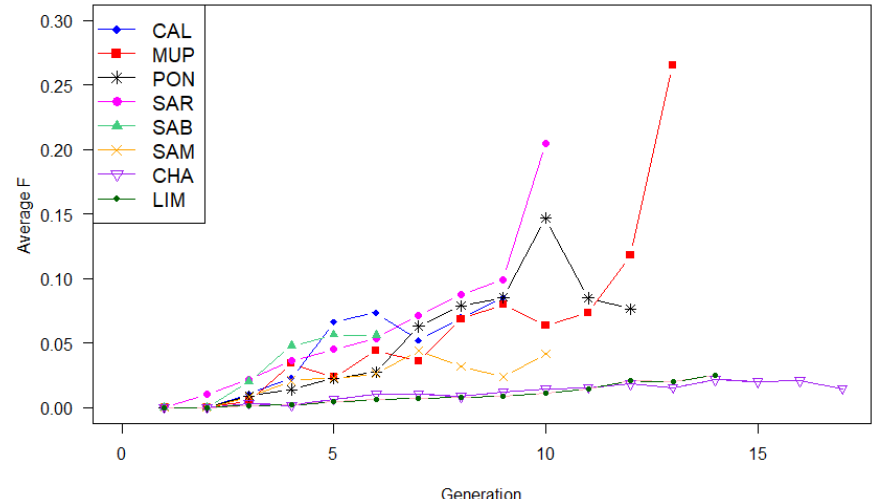
Figure 1. Rate of inbreeding ( ΔF ) per generation for each breed, where CAL = Calvana; MUP = Mucca Pisana; PON = Pontremolese; SAR = Sarda; SAB = Sardo Bruna; SAM = Sardo Modicana; CHA = Charolais; LIM = Limousine. Table 5. Population parameters for each